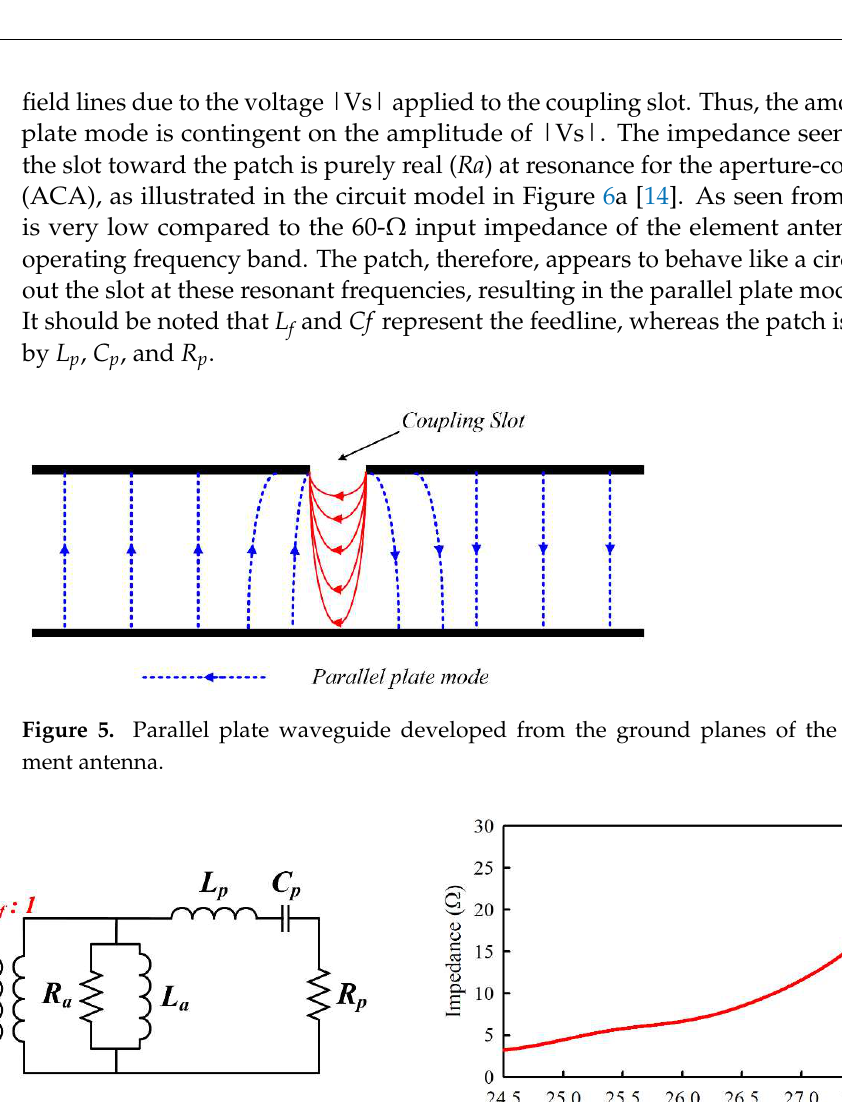
Figure 4. Simulated results of the proposed element antenna. ( a ) |S11|. ( b ) Radiation patterns at 26.2 GHz.